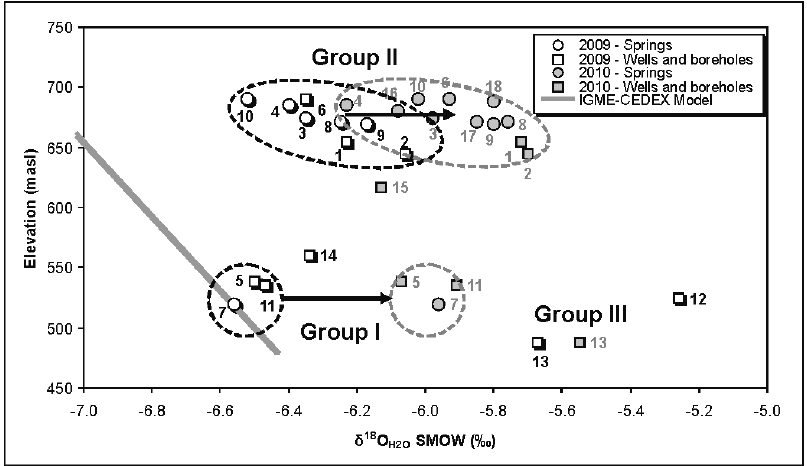
Figure 8. δ 18 O-elevation relationship. Note: the thick line is the model of δ 18 O in precipitation in the Sierra de Cañete groundwater body.